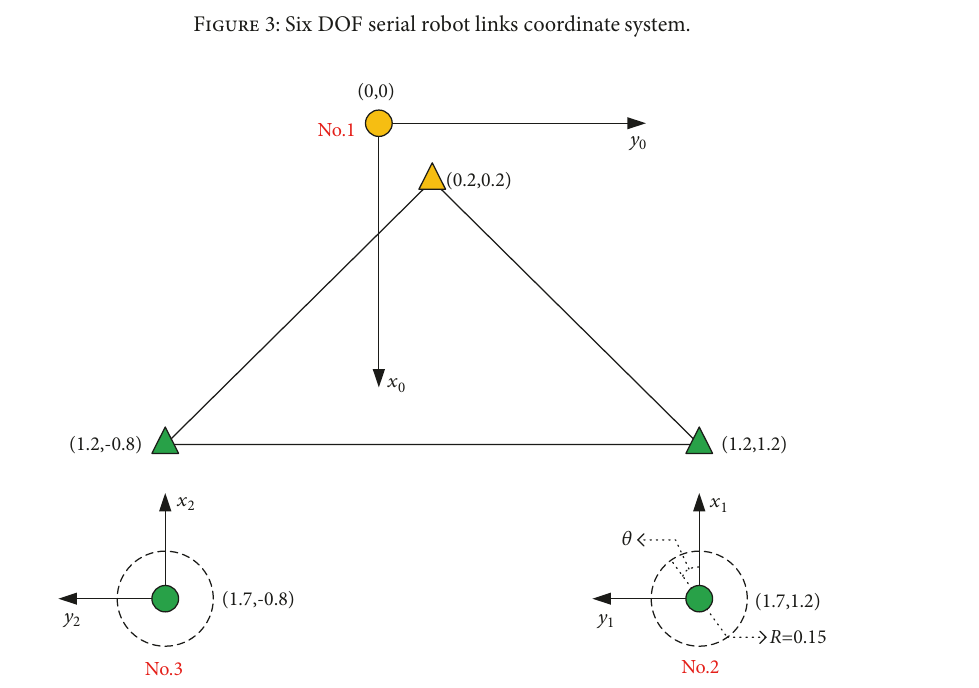
Figure 4: The coordinate systems diagram of the EPR layout. Table 4: Six DOF serial robot parameters of